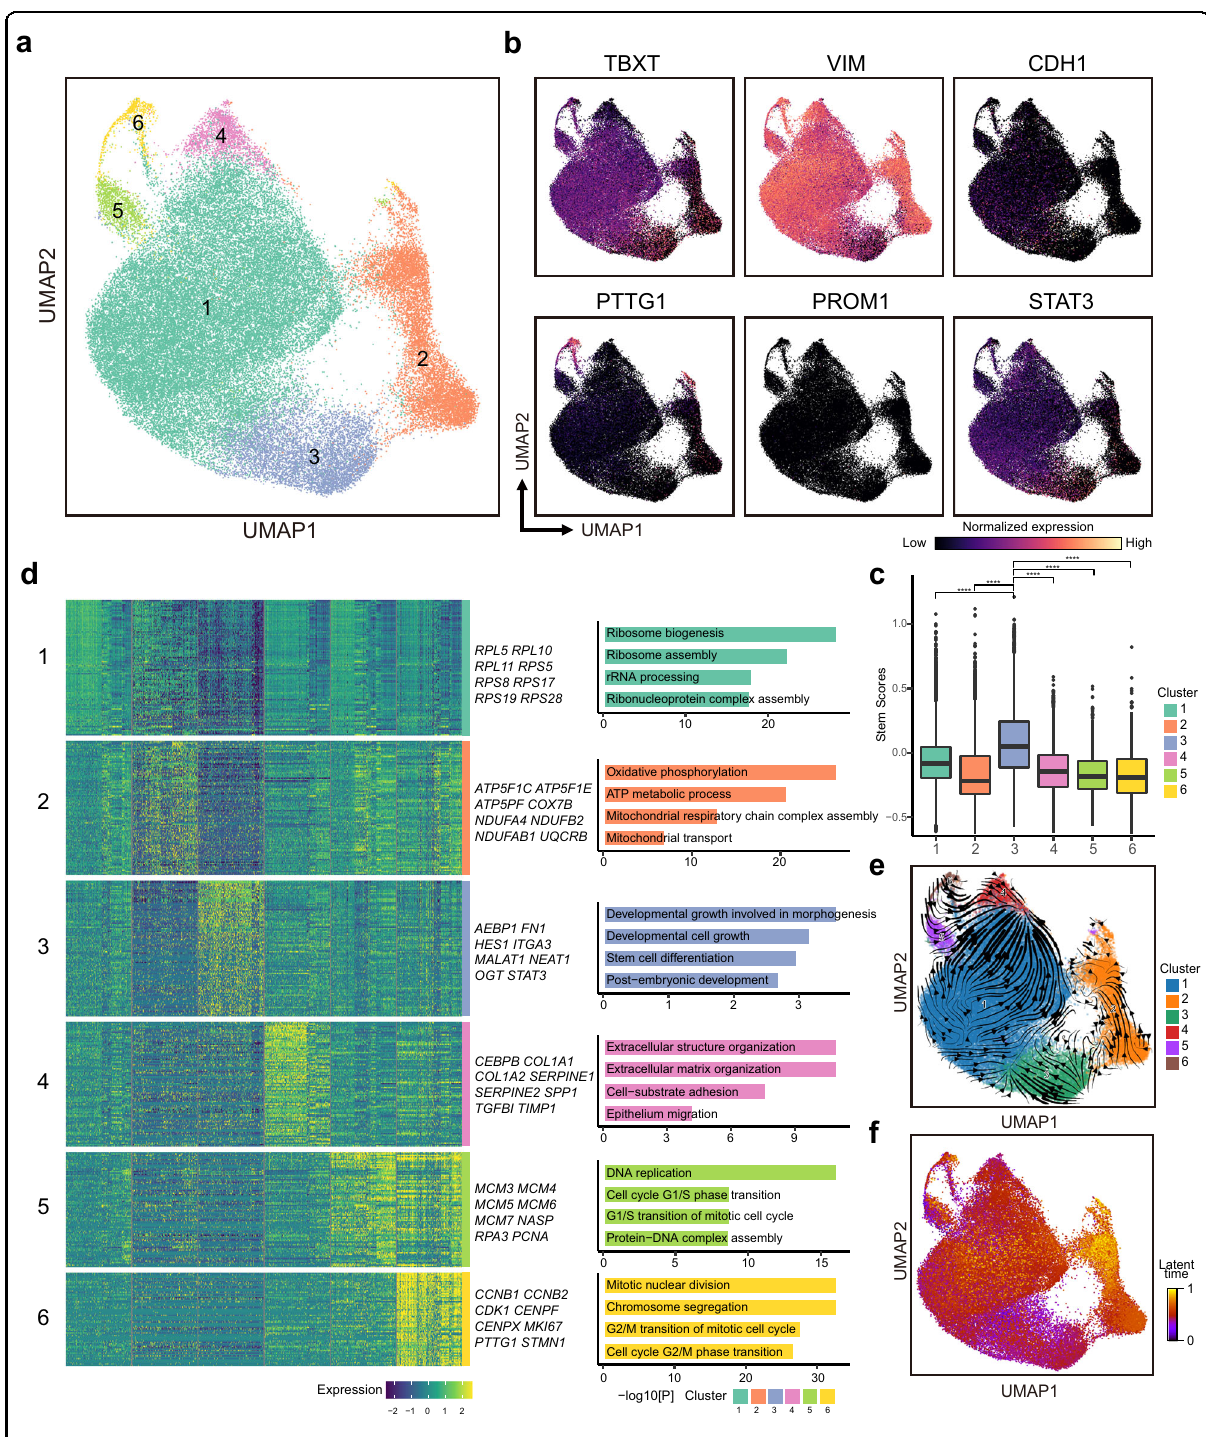
Fig. 3 Expression heterogeneity and stem-like malignant cells in SBC. a 60,626 malignant cells were clustered into six clusters using unbiased clustering. b The UMAP plot of the expression of SBC subpopulation and cancer stem-cell markers. c Stem score was calculated in each malignant cluster. Cluster 3 showed the highest stem score. **** P -value ≤ 0.0001. d The heatmap showed the markers and pathway enrichment results of each SBC malignant cluster. Genes with high expression levels were labeled on the right side of the heatmap. e , f The RNA velocity trajectory and the latent time of SBC malignant